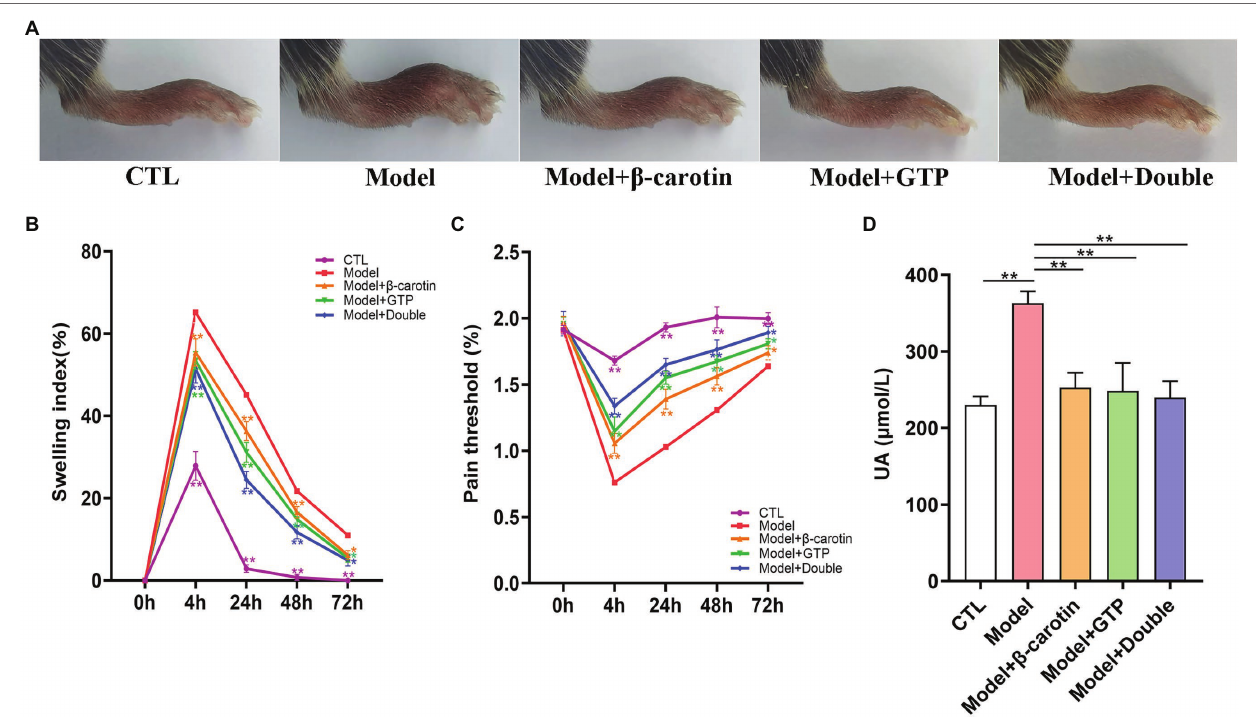
FIGURE 1 | Effects of β -carotin and green tea powder on alleviating the symptoms of gout in mice. (A) Representative images of foot joints in five groups of mice. (B) Level of footpad swelling in five groups of mice. (C) Level of footpad pain threshold in five groups of mice. (D) Level of serum uric acid (UA) in five groups of mice. * p < 0.05, ** p <